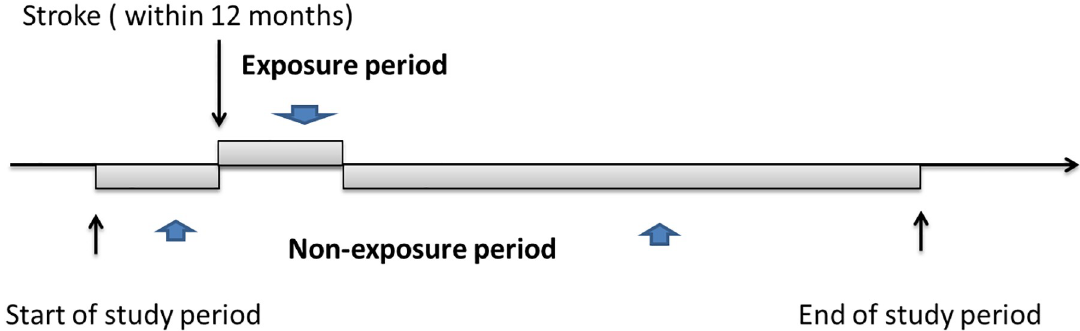
Fig 1. Pictorial representation of the self-controlled case series